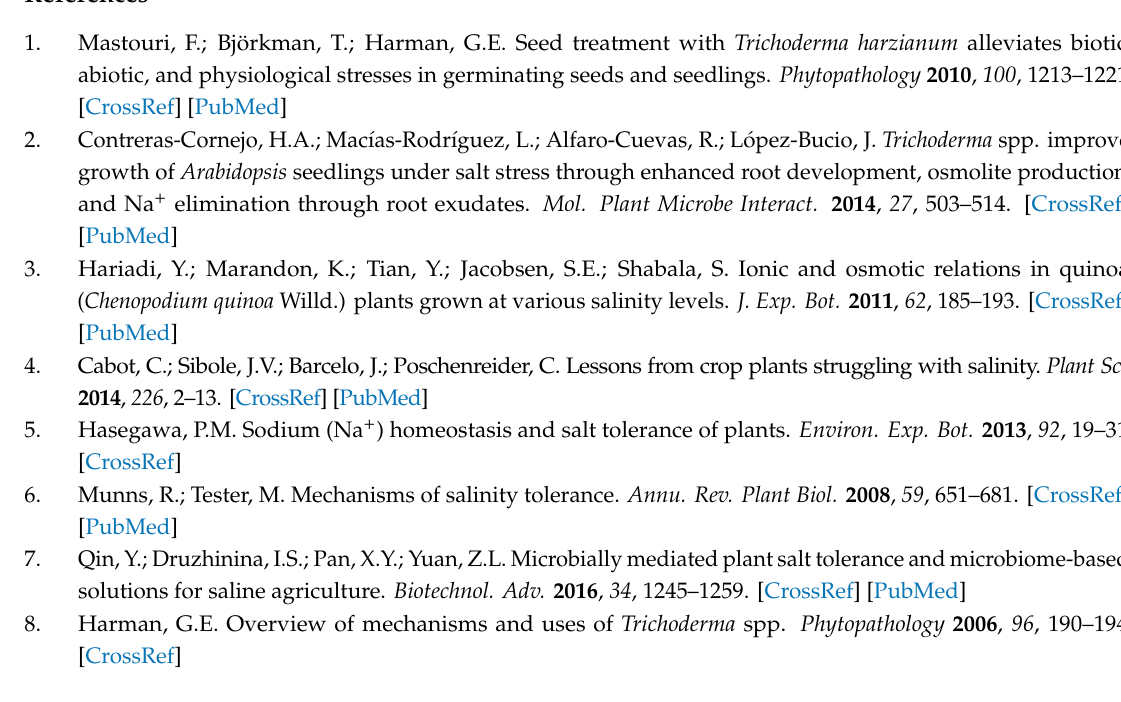
Note: F represents forward, R represents